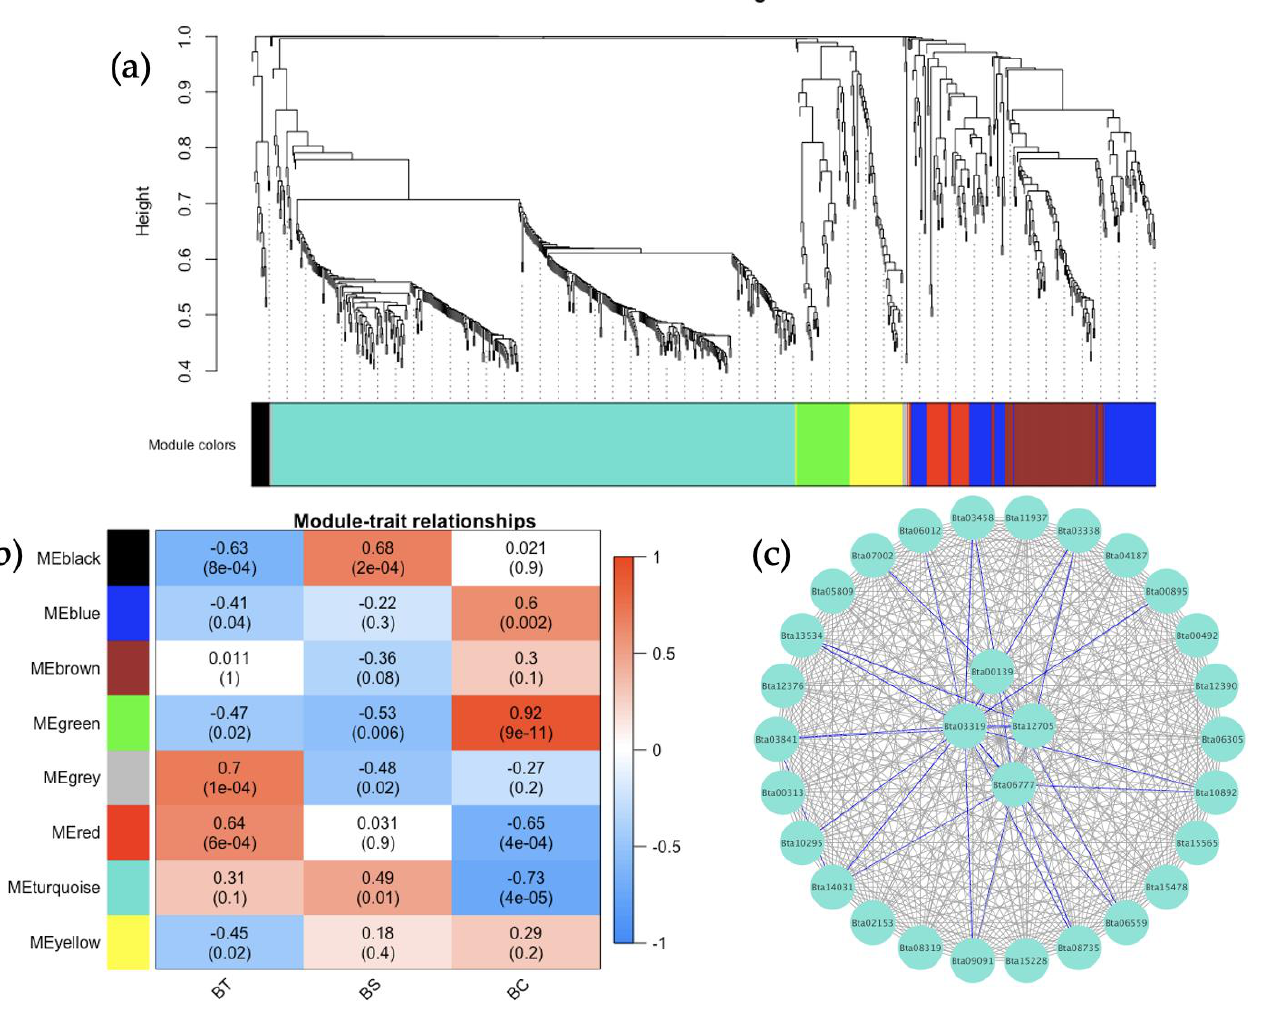
Figure 6. Bemisia tabaci Middle East-Asia Minor 1 (MEAM1) adults weighted gene co-expression network analysis. ( a ) Dendrogram clustering showing eight modules of co-expressed genes. A total of 784 genes are represented in this network, with 454 genes belonging to MEturquoise. ( b ) Heatmap showing the correlation of module eigengenes in relation to B . tabaci MEAM1 that acquired TYLCV (BT), SiGMV (BS), or CuLCrV (BC). ( c ) Top 30 genes from MEturquoise with connectivity lines (blue) associated with the top 5% of the connected